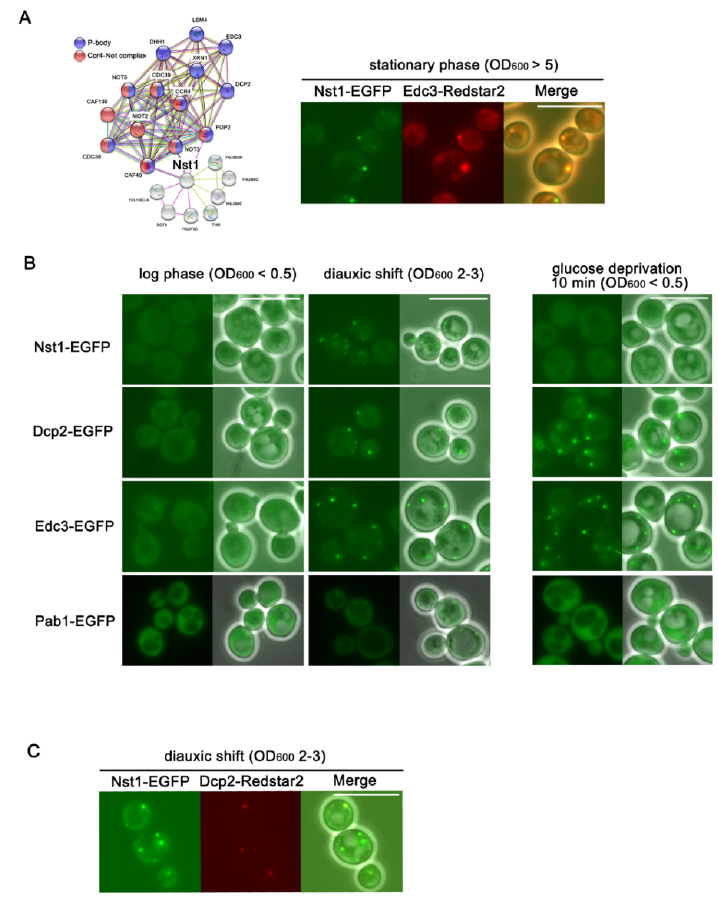
Figure 1. Nst1 is densely associated with PBs in post-exponential growth phase cells of Saccharomyces cerevisiae. ( A ) The Nst1 protein–protein interaction network with PB components including Ccr4-Not complex was visualized using STRING (functional enrichment analysis of protein–protein inter- action networks, https://string-db.org/, accessed on 7 January 2022). The purple dots represent previously known PB components, and the red dots indicate components of the Ccr4-Not complex. Co-localization of the endogenous EGFP-tagged Nst1 and Redstar2-tagged Edc3 (YSK 3520) in w303a cells of stationary phase (OD 600 > 5). Scale bar, 10 µ m. ( B ) Fluorescence microscopy of w303a cells endogenously expressing Nst1-EGFP, Dcp2-EGFP, Edc3-EGFP, and Pab1-EGFP in the exponential growth (logarithmic phase), diauxic shift, and glucose-depleted stress condition. YSK3524, YSK3527, YSK3528, and YSK3525 strains, primarily expressing EGFP-fused Nst1, Dcp2, Edc3, and Pab1 respec- tively, were observed at log phase (OD 600 < 0.5) and diauxic shift (OD 600 of 2–3). Log phase cells (OD 600 < 0.5) were washed three times with glucose-depleted synthetic medium and additionally incubated for 10 min to induce glucose deprivation. Scale bar, 10 µ m. ( C ) Co-localization of the endogenous EGFP-tagged Nst1 and Redstar2-tagged Dcp2 (YSK3509) in w303a cells of diauxic shift (OD 600 2–3). Scale bar, 10 µ